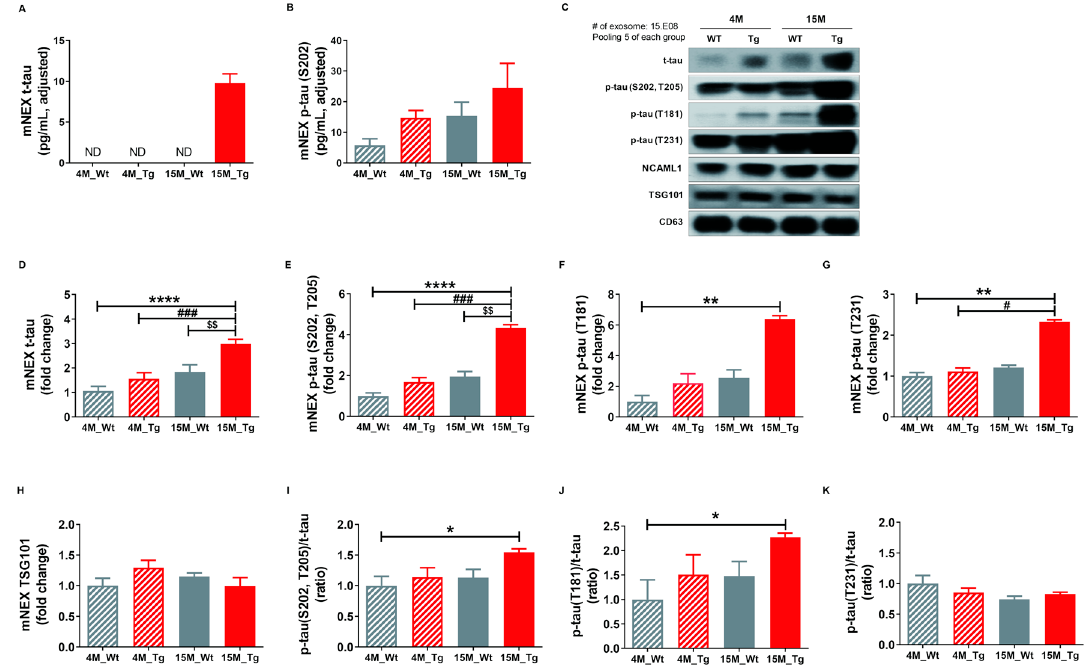
Figure 6. Total tau and phosphorylated tau protein levels in NEX from the blood of JNPL3 mice increase with the progression of pathology. ( A ) Total tau (t-tau) and ( B ) p-tau (S202) in mouse neuronal cell-derived exosomes (mNEX) were quantified using ELISA. 4M-WT ( n = 5), 4M-Tg ( n = 10), 15M-WT ( n = 11), and 15M-Tg ( n = 17). ( C – K ) mNEX t-tau and p-tau (S202) were higher in 15M-Tg mice. mNEX t-tau and p-tau expression were validated by Western blot. C ) Representative Western blot. Relative expression levels of ( D ) t-tau, ( E ) hyperphosphorylated tau (p-tau (S202, T205)), ( F ) p-tau (T181), ( G ) p-tau (T231), and ( H ) TSG101 as well as ( I ) p-tau (S202, T205) / t-tau ratio, ( J ) p-tau (T181) / t-tau ratio, and ( K ) p-tau (T231) / t-tau ratio in mouse NEX (mNEX). mNEX t-tau and p-tau (S202, T205) were higher in 15M-Tg mice compared to 4M-WT, 15M-WT, and 15M-Tg mice. mNEX p-tau (T181), p-tau (S202, T205) / t-tau ratio, and p-tau (T181) / t-tau ratio were higher in 15M-Tg mice compared to 4M-WT mice. mNEX p-tau (T231) was higher in 15M-Tg mice compared to 4M-WT and 4M-Tg mice. All data were shown as means ± SEM ( n = 14 per group). * p < 0.05, ** p < 0.01, and **** p < 0.0001 compared to 4M-WT, # p < 0.05 and ### p < 0.001 compared to 4M-Tg, and $$ p < 0.01 compared to 15M-WT mice by one-way ANOVA and Bonferroni’s multiple comparison test.